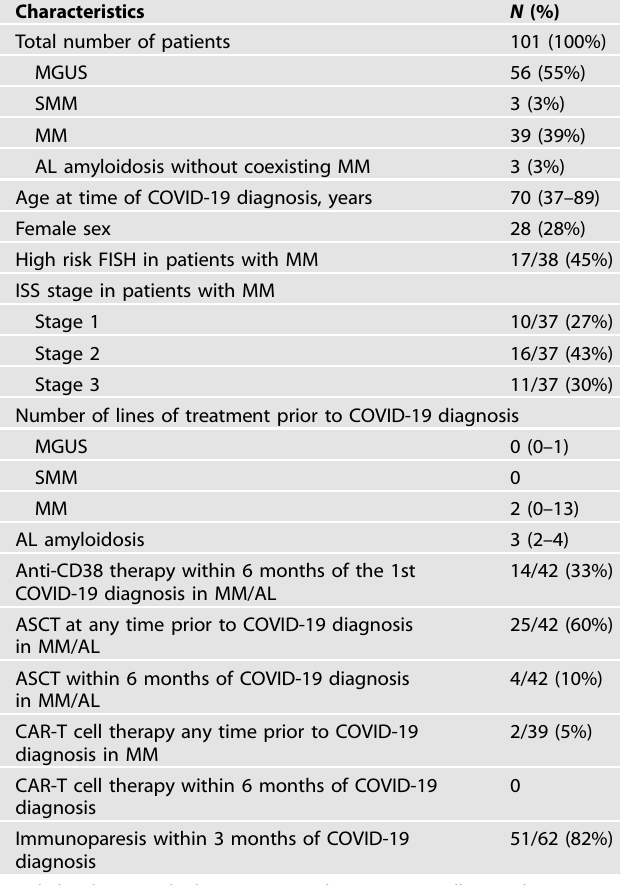
Table 1. Baseline characteristics for the study cohort.